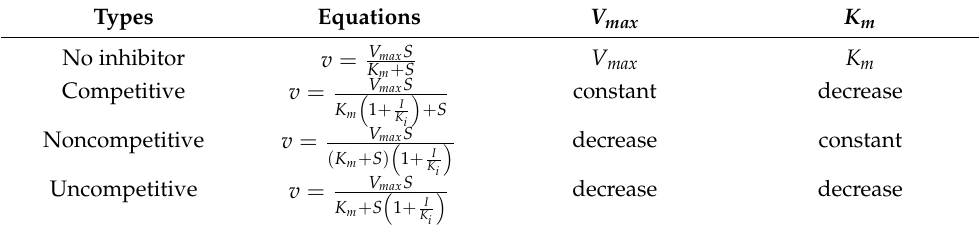
Table 2. Michaelis–Menten equation and constants for different inhibition